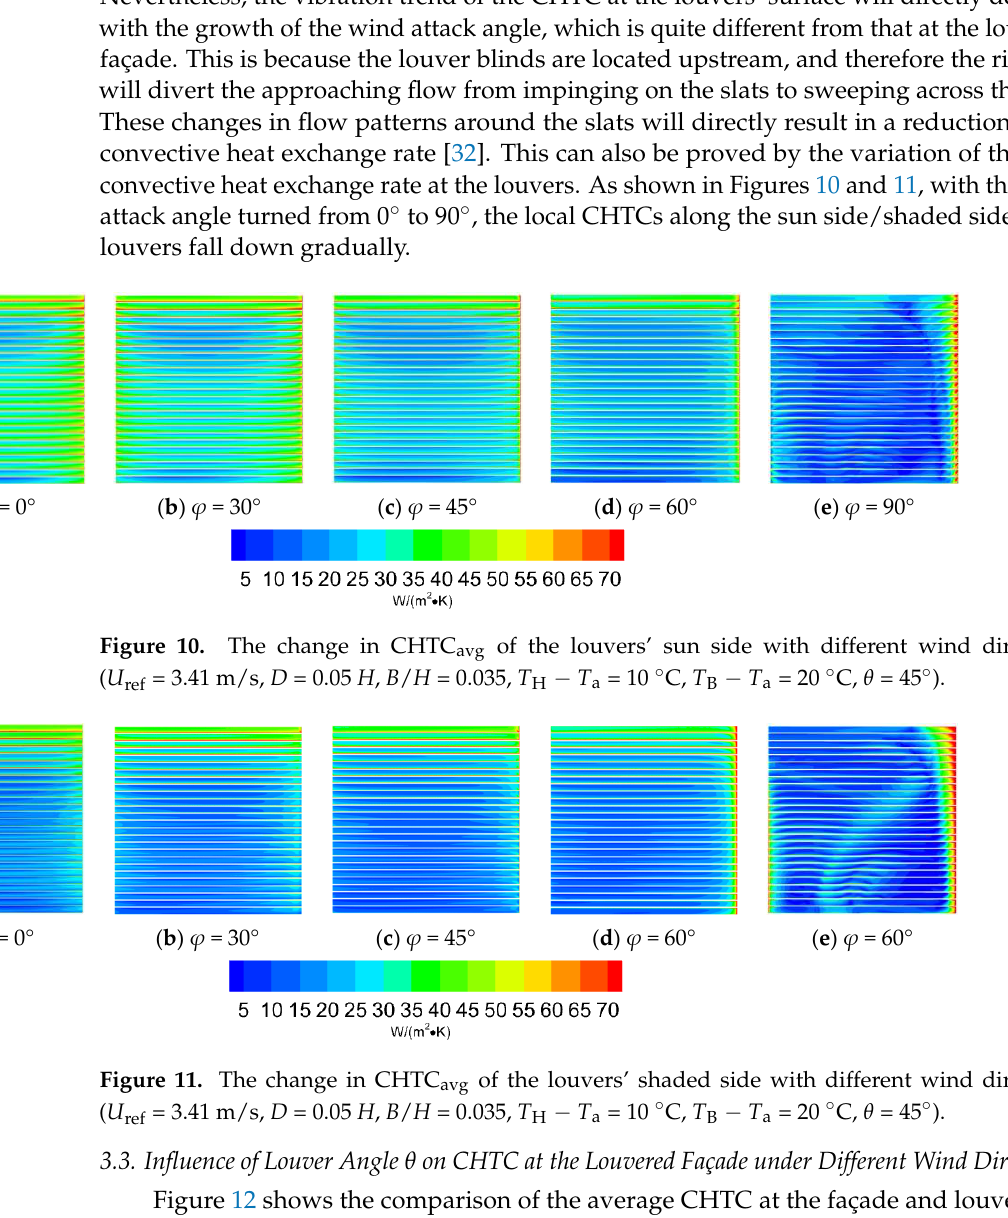
Figure 9. The change in CHTC avg of the louvered façade with different wind directions ( U ref = 3.41 m/s, D = 0.05 H , B / H = 0.035, T H − T a = 10 °C, T B − T a = 20 °C, θ = 45°).